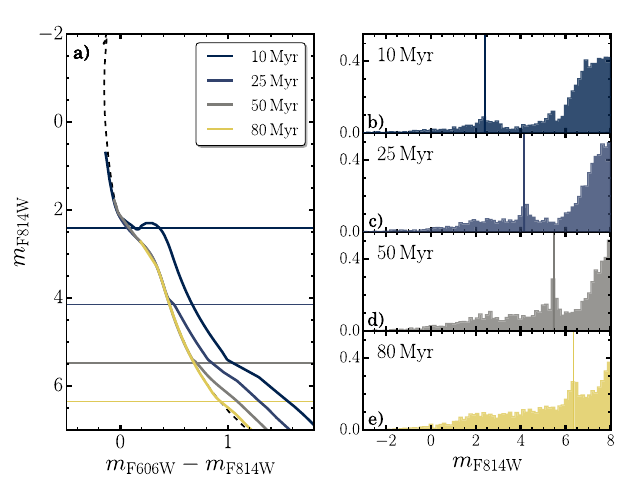
Fig.3|Theturn-ontodatestellarpopulations.a Isochronesdifferentages,from 10 to 80Myr, computed with the Padova models 47 . The age of each isochrone is indicatedinthetoprightlegend.Theblackshadedlineindicatesthezero-agemain- sequence (ZAMS), while the horizontal lines mark the magnitude of the turn-on of each stellar population. b – e Luminosity function of stellar populations with the same ageasthe isochrones shown in( a ).Theverticallinesmarkthe locationofthe main-sequenceturn-ondistinguishableasapeakineachLFs.Theageofeachstellar populations is indicated in the top left corner.